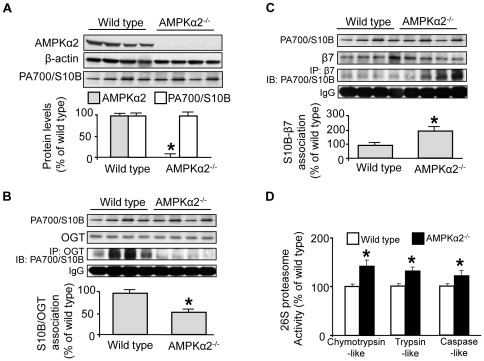
AMPK depletion is associated with decreased association of OGT with proteasome and increased 26S proteasome assembly and activity in AMPK-KO mice.Gender (male) and age (12 weeks) matched mice (n = 8/group) with the genotypes of wild type (C57BL/6J) and AMPKα knockout were used. Compared to aortas from wild type (C57BL/6J) mice, (A) aortas from AMPKα knockout mice exhibit (B) a decrease in the association of OGT with proteasome (PA700/S10B), (C) an increase in proteasome assembly (PA700/S10B-β7 association), and (D) an increase in 26S proteasome activity, without alteration in the expression levels of proteasome (β7 or PA700/S10B) or OGT. * represents p<0.05 vs wild type (n = 8).